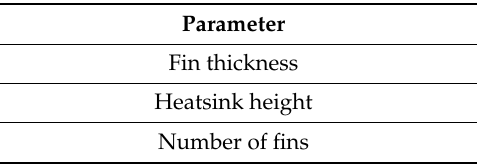
Table 4. Full factorial parameter